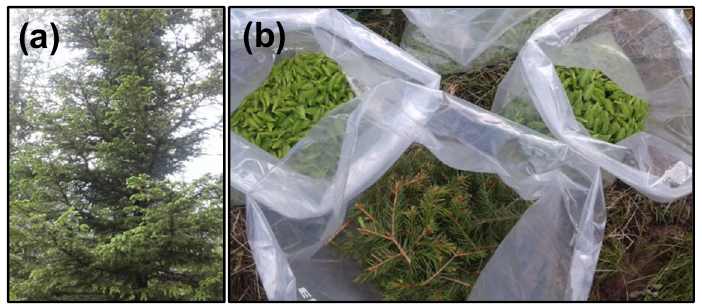
Figure 8. A typical young sample tree of Norway spruce in Nothern Finland ( a ): sprouts and needles were collected into plastics bags and immediately put into a freezer ( b ).